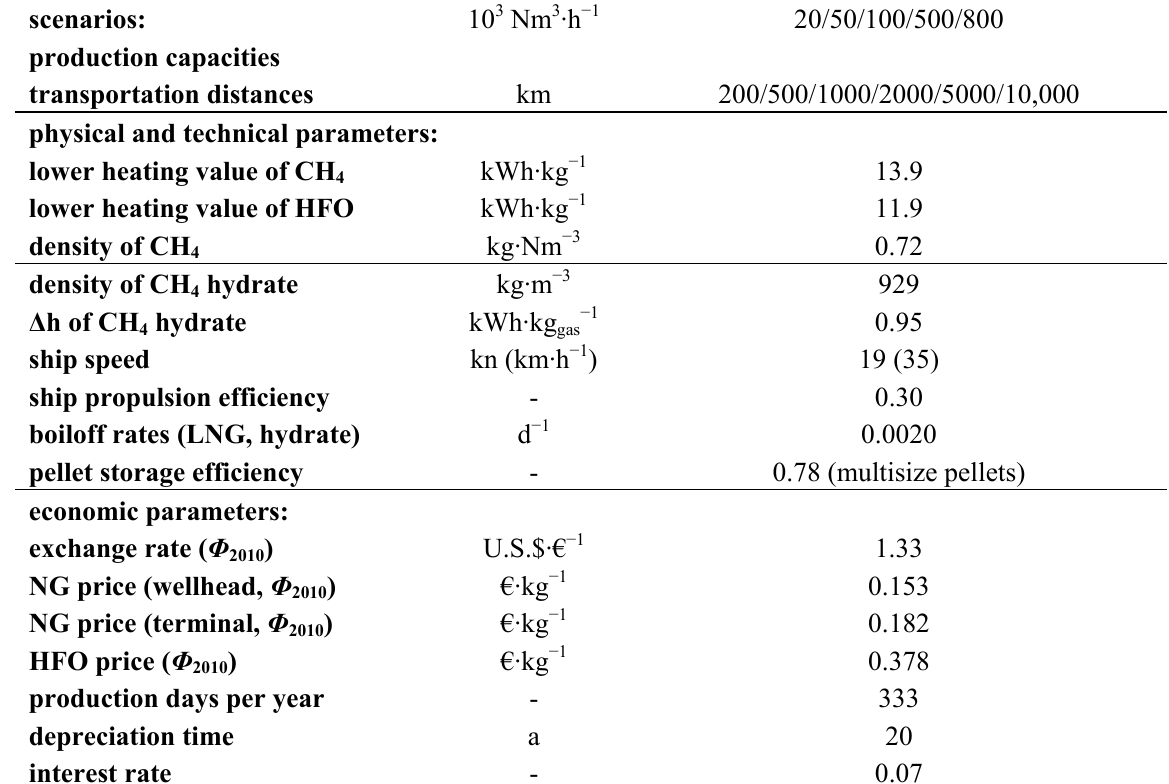
Table 4. Scenarios and model parameters for the comparative assessment of transport